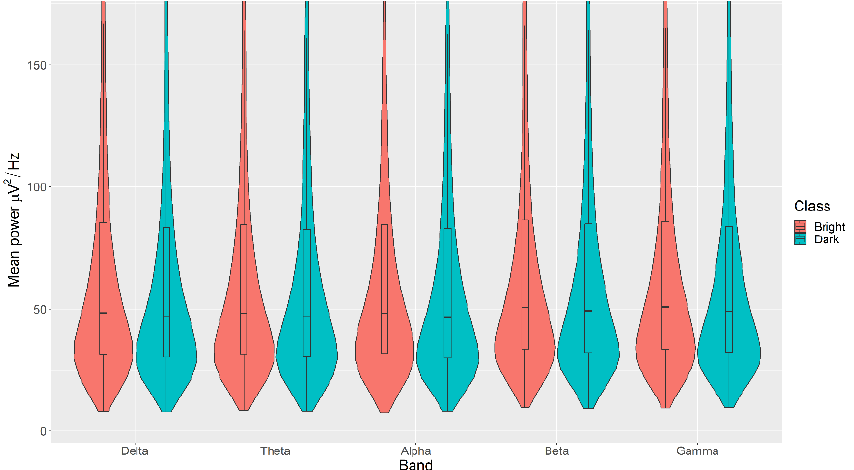
Figure 6. Violin plot of the average power in each of the bands for Bright and Dark categories for the Light VDEP, ranging from low ( δ delta) to high ( γ gamma) frequencies.